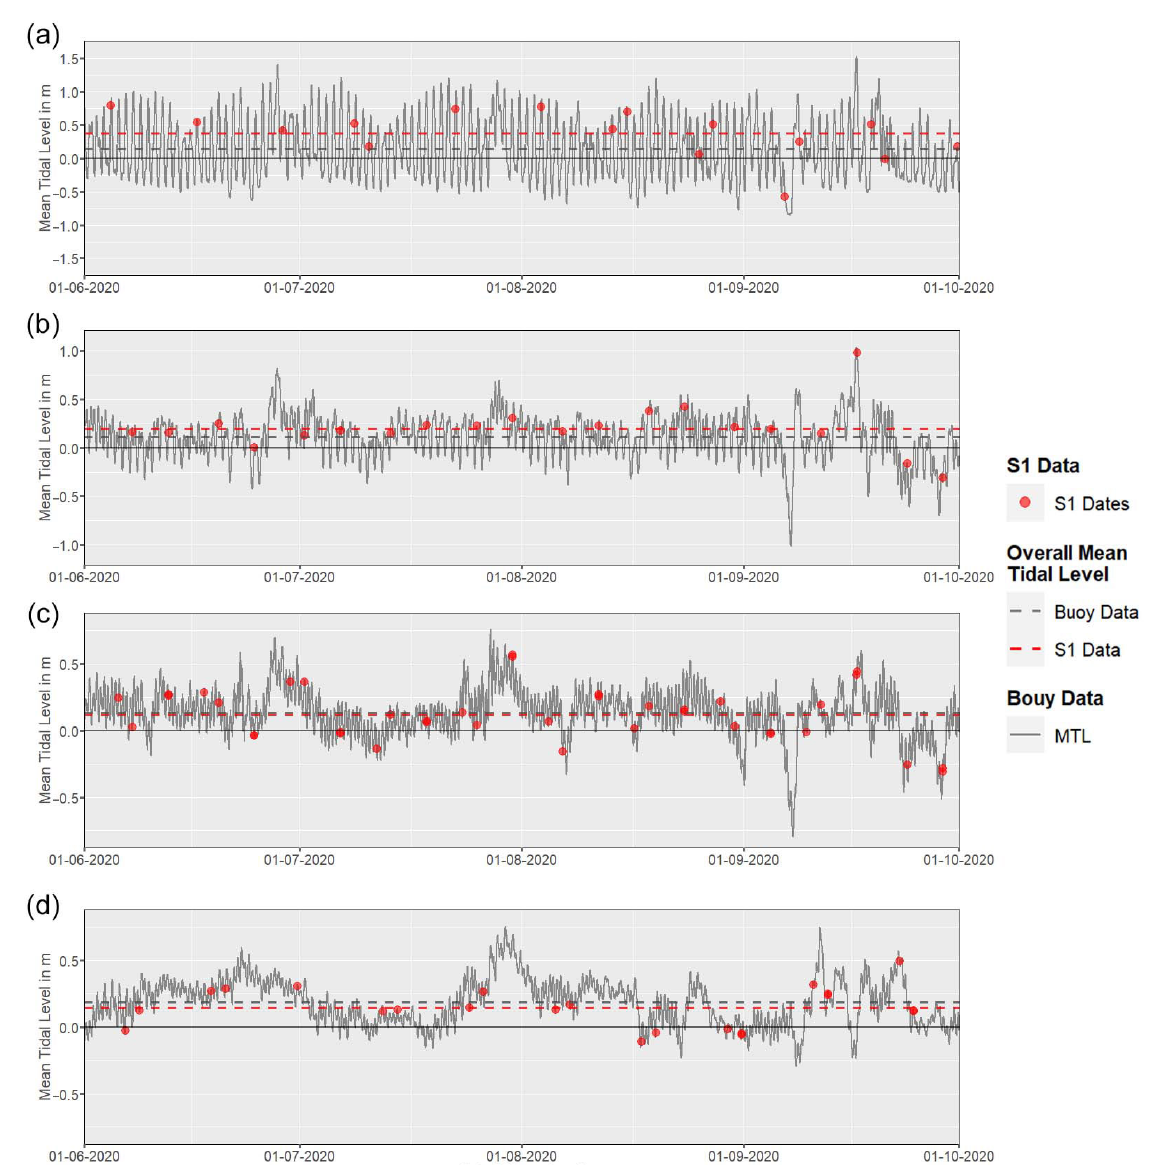
Figure 10. Mean Tidal Level (MTL) in m based on 6 min buoy data from June 1st to September 30th 2020 for the stations 9468333 Unalakleet ( a ), 9468756 Nome ( b ), 9491094 Red Dog Dock ( c ), and 9497645 Prudhoe Bay ( d ) provided by the National Oceanic and Atmospheric Administration (NOAA) [54]. The red points represent the MTL at Sentinel-1 (S1) acquisition times for the respective region. The dashed lines represent the overall MTL from June–September based on the full buoy dataset (grey line) and the tidal levels at the S1 acquisition times (red